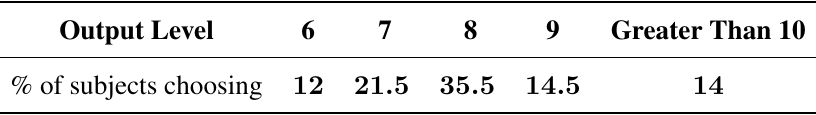
Table 5. Distribution of output levels in Huck et al.